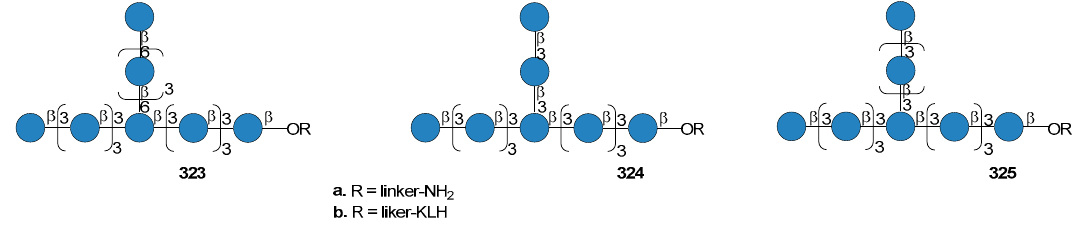
Figure 35. Structure of fragments 285a – 287a and their KLH conjugates [249].